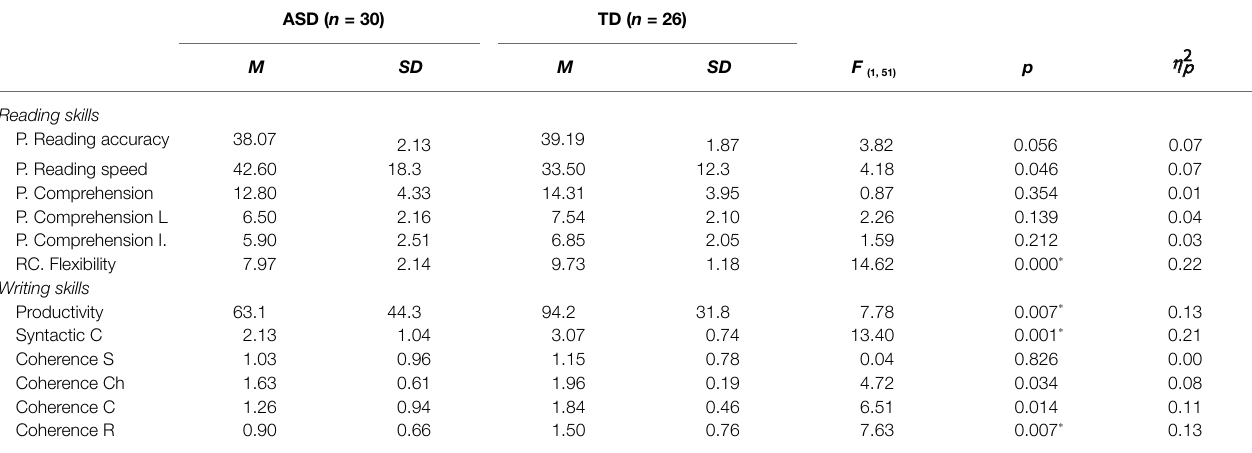
TABLE 2 | Means, standard deviations (SD) of reading and writing skills, and statistically significant differences between ASD and TD adolescents.